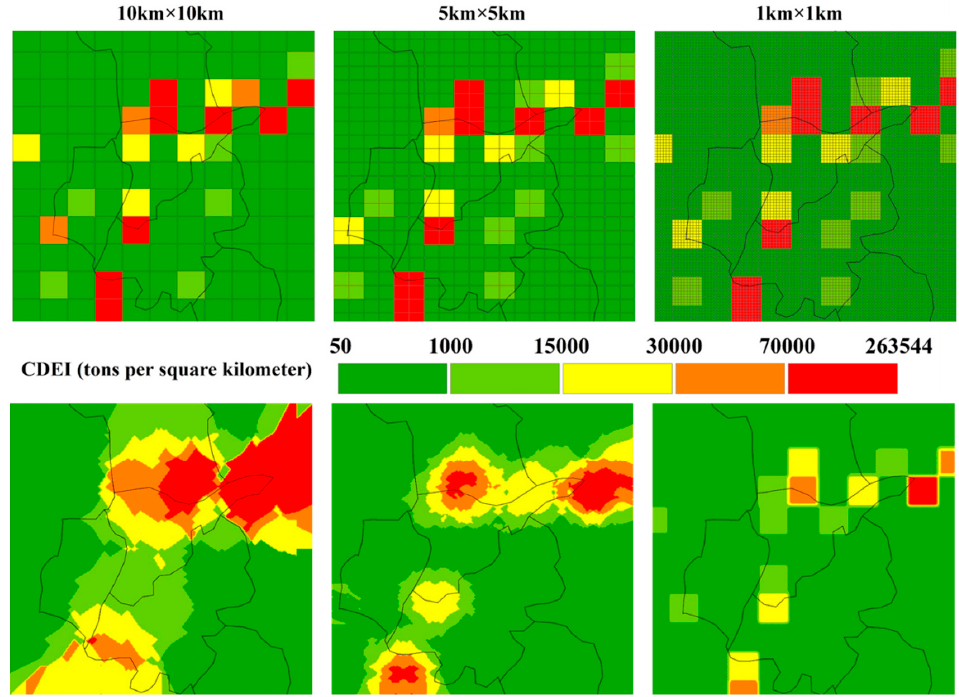
Figure 3. Different resolution and spatial interpolation maps of the study